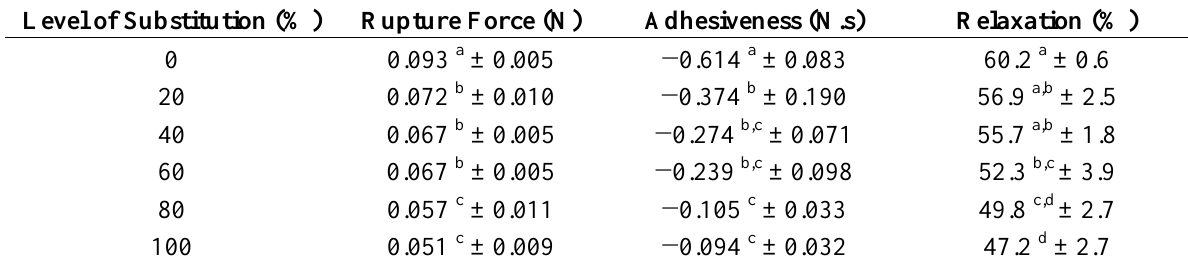
Table 4. Summary of the mean rupture force, adhesiveness and relaxation of yogurt gels, as a function of percent substitution of powdered skim milk with whey:buttermilk aggregate enriching the starting milk. A Duncan post-test was applied to compare the means to the